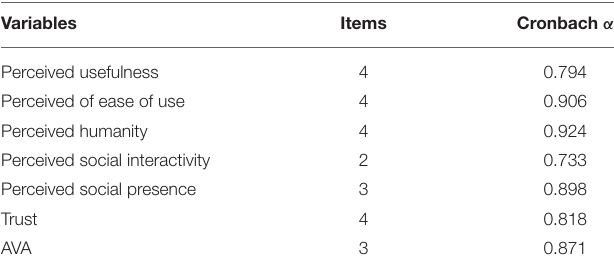
TABLE 3 | Reliability test